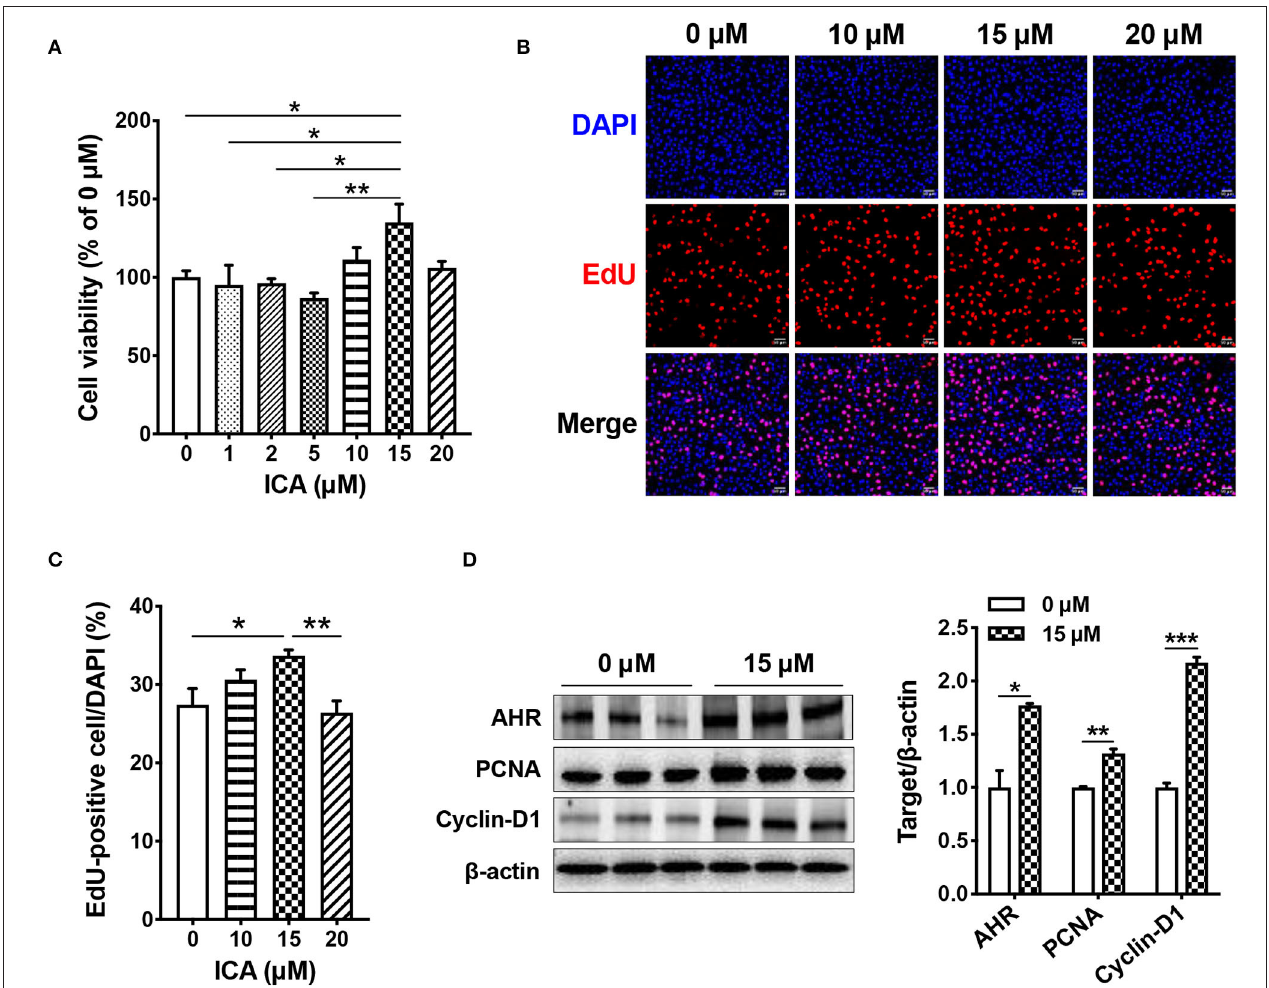
FIGURE 6 | ICA accelerates the proliferation of intestinal epithelial cells in vitro . IPEC-J2 cells were treated with different doses of ICA for 24h. The cell viability was determined by CCK8 assay (A) . The cell proliferation was determined by EdU incorporation assay (B,C) . Cells were stained for EdU (red), and the nuclei were stained with DAPI (blue). The expression of AHR, PCNA, and Cyclin D1 were measured by western blot (D) . Data are expressed as mean ± SEM. * P < 0.05, ** P < 0.01, *** P < 0.001 vs. the Control group. ICA100, the basal diet supplemented with 100 mg/kg indole-3-carboxaldehyde. AHR, aryl hydrocarbon receptor; PCNA, proliferating cell nuclear antigen.